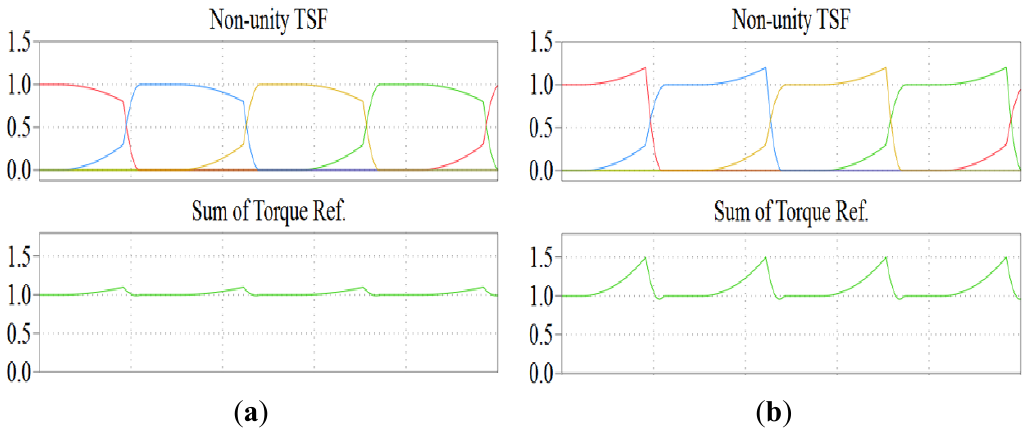
Figure 8. Sum of torque reference according to k 3 and k 4 : ( a ) 10%; ( b )